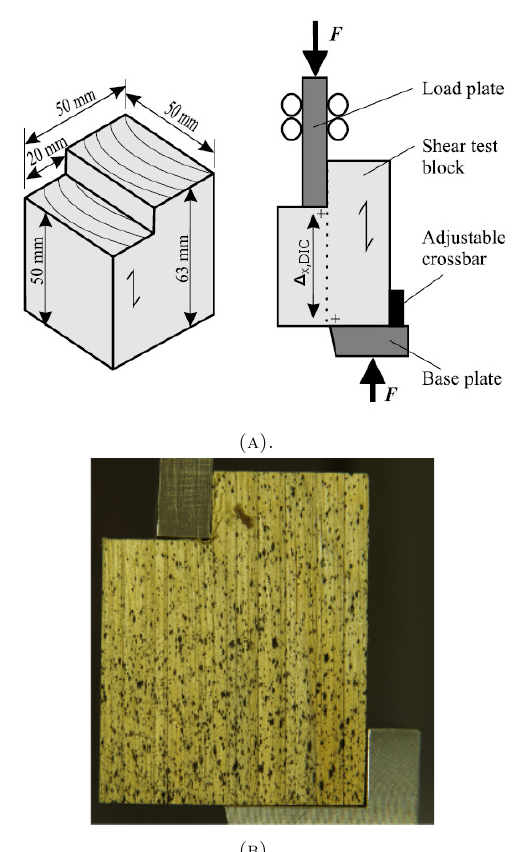
Figure 2. Shear-parallel-to-grain test according to the standard ASTM D143-94: (A) set-up and rela- tive vertical displacement ∆ x,DIC calculated by DIC analysis, (B) a mounted specimen. [3] The load was applied with the crosshead displacement control at a rate of 0 . 6 mm / min.